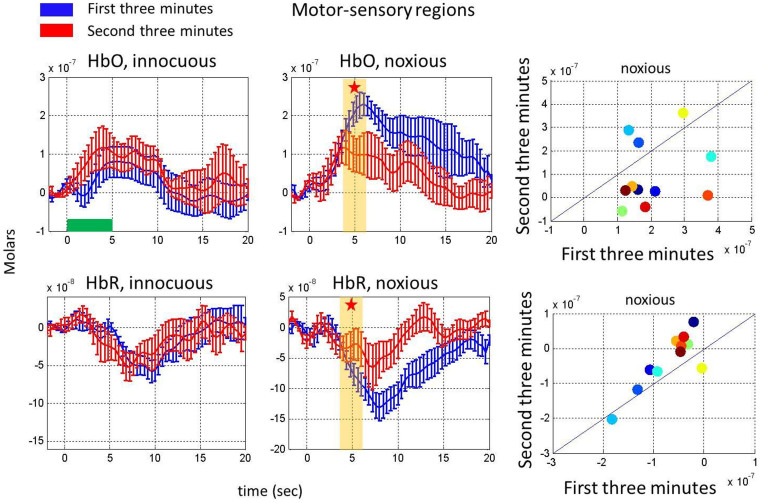
Habituation in the hemodynamic response to noxious stimuli on the motor-sensory region.Comparison of HbO (top, left panels) and HbR changes (bottom, left panels) in response to innocuous and noxious electrical stimuli in the first three minutes (blue) with the HbO and HbR changes in the second three minutes (red). Error bars represent the standard error across subjects (n = 11). Yellow bars show the interval chosen to obtain the mean response depicted for each subject in the scatter plots and stars indicate a statistically significant difference. The right panels show scatter plots comparing the hemodynamic response averaged over the yellow bar during the first and second three minutes for HbO (top) and HbR (bottom). The horizontal green bar shows the stimulus duration.